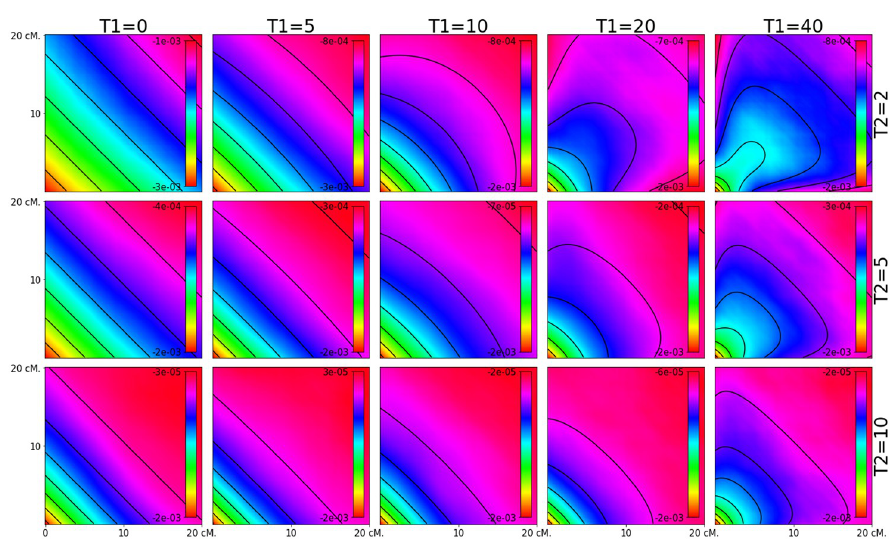
Fig 1. Predicted weighted LD surfaces from simulations and theory for varying admixture times. The heat maps are from simulations and the contours are plotted from Eq 7. The two admixture probabilities were fixed at m 1 = m 2 = .2 and the the times of the two admixture pulses, T 1 and T 2 , were varied. Each square covers the range 0.5 cM < d , d 0 < 20 cM. When time of the more recent pulse is greater than half of that of the more ancient pulse, i.e. 2 T 1 > T 1 + T 2 , the contours of the resulting weighted LD surface are straight, making it difficult to distinguish from the weighted LD surface produced by a one-pulse admixture scenario.